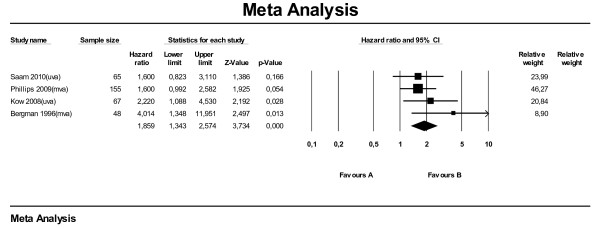
Meta-analysis of univariate and multivariate data sets for predictive value of location of tumor (LOC) on survival time using hazard ratios.